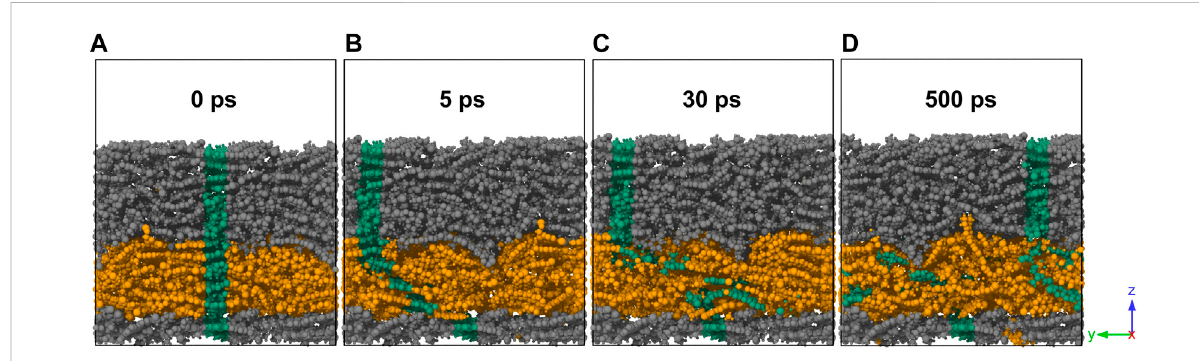
Con fi guration change at different shear friction times.